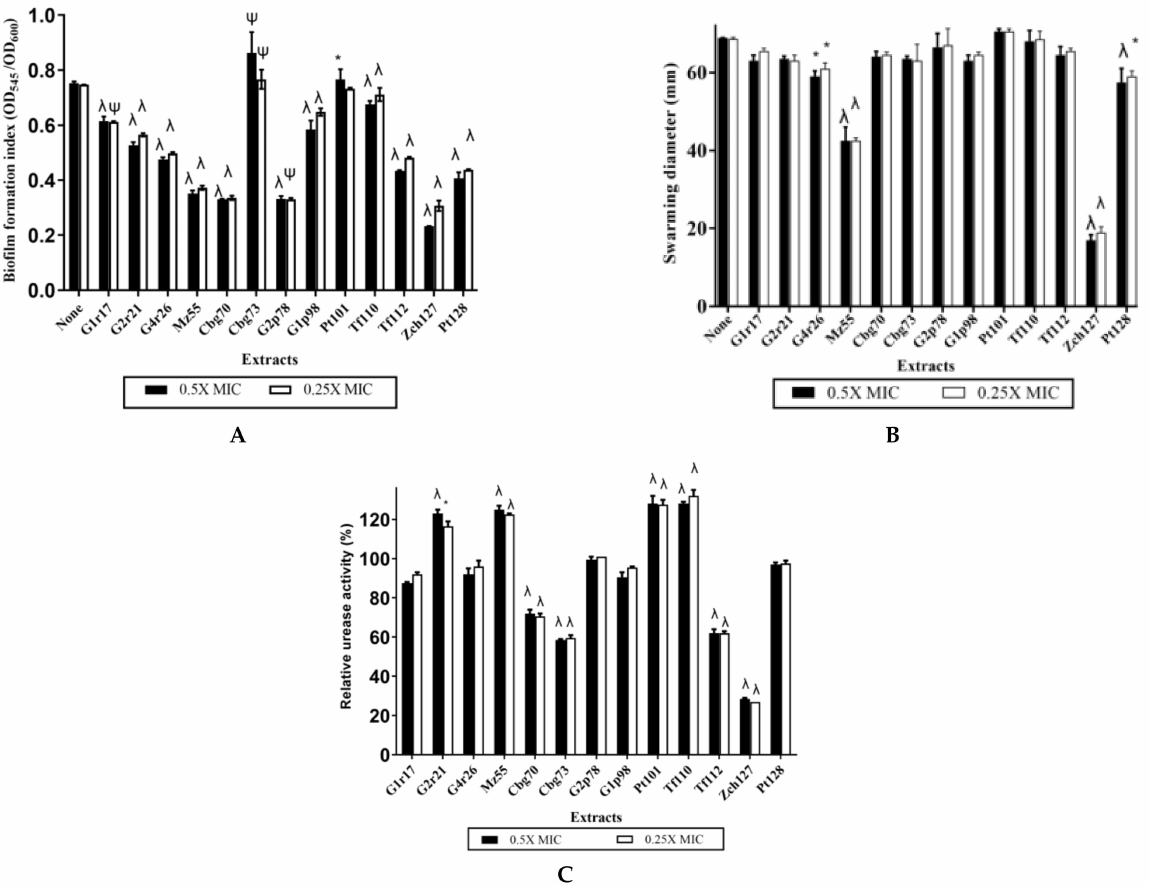
Figure 1. Antivirulence activity of 13 bacterial culture extracts on P. mirabilis P1 isolate. The effect of 0.5X of minimum inhibitory concentration (MIC) (Extracts no. G1r21, Cbg73, G2p78: 1.25 mg/mL, G1r17, G1p98, Zch127: 0.625 mg/mL extracts no. Mz55, Tf110, Tf112, Pt128: 0.312 mg/mL, extracts no. Pt101: 0.156 mg/mL and extracts G4r26, Cbg70: 0.08 mg/mL) and 0.25X MIC of the bacterial culture extracts containing indole derivatives on P. mirabilis isolate P1 ( A ) Normalized biofilm formation, ( B ) Diameter of swarming motility, and ( C ) Relative urease activity, where the values were obtained in the absence of extracts after 3 h of incubation were set as 100 %, and all other values were expressed relative to this value. Data represents the mean of at least 3 biological replicas. Statistical analysis using two-way ANOVA, which was followed by multiple comparisons test with a significance level at * p < 0.05; ψ p < 0.01; λ p <